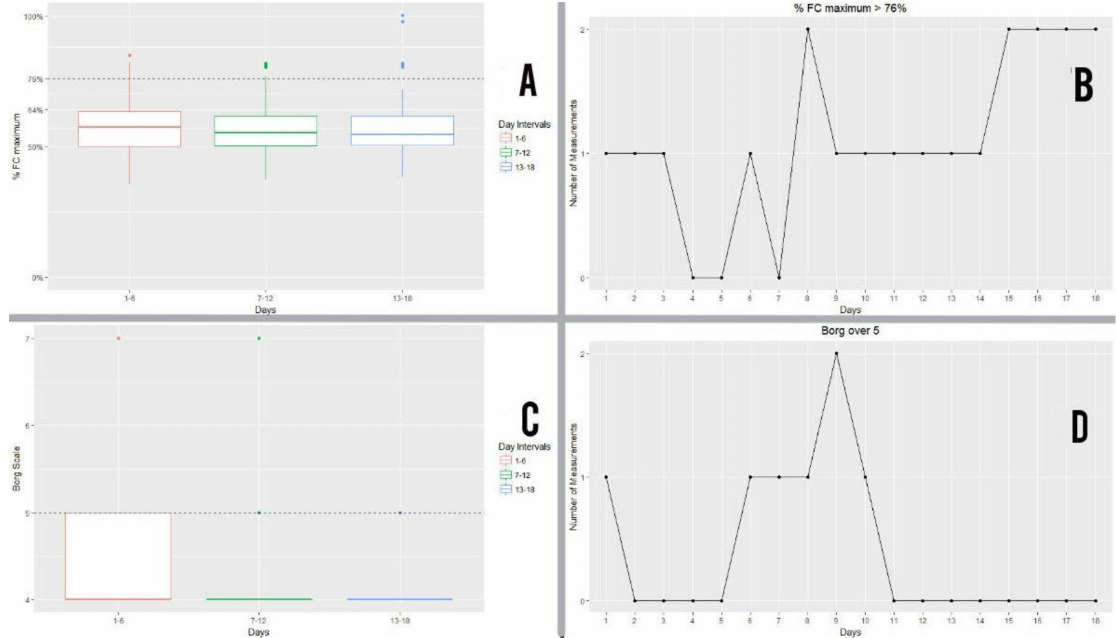
Figure 10. ( A ) Results of the maximum heart rate percentage for the study group during exercise, grouped together into 6-day intervals. ( B ) Number of % heart rate measurements (% FCmaximun) which were above the cut-off point per day. ( C ) Results of the intensity of perceived exertion according to the Borg scale for the study group during exercise, grouped together into 6-day intervals. ( D ) Number of perceived exertion measurements (Borg) which were above the cut-off point per